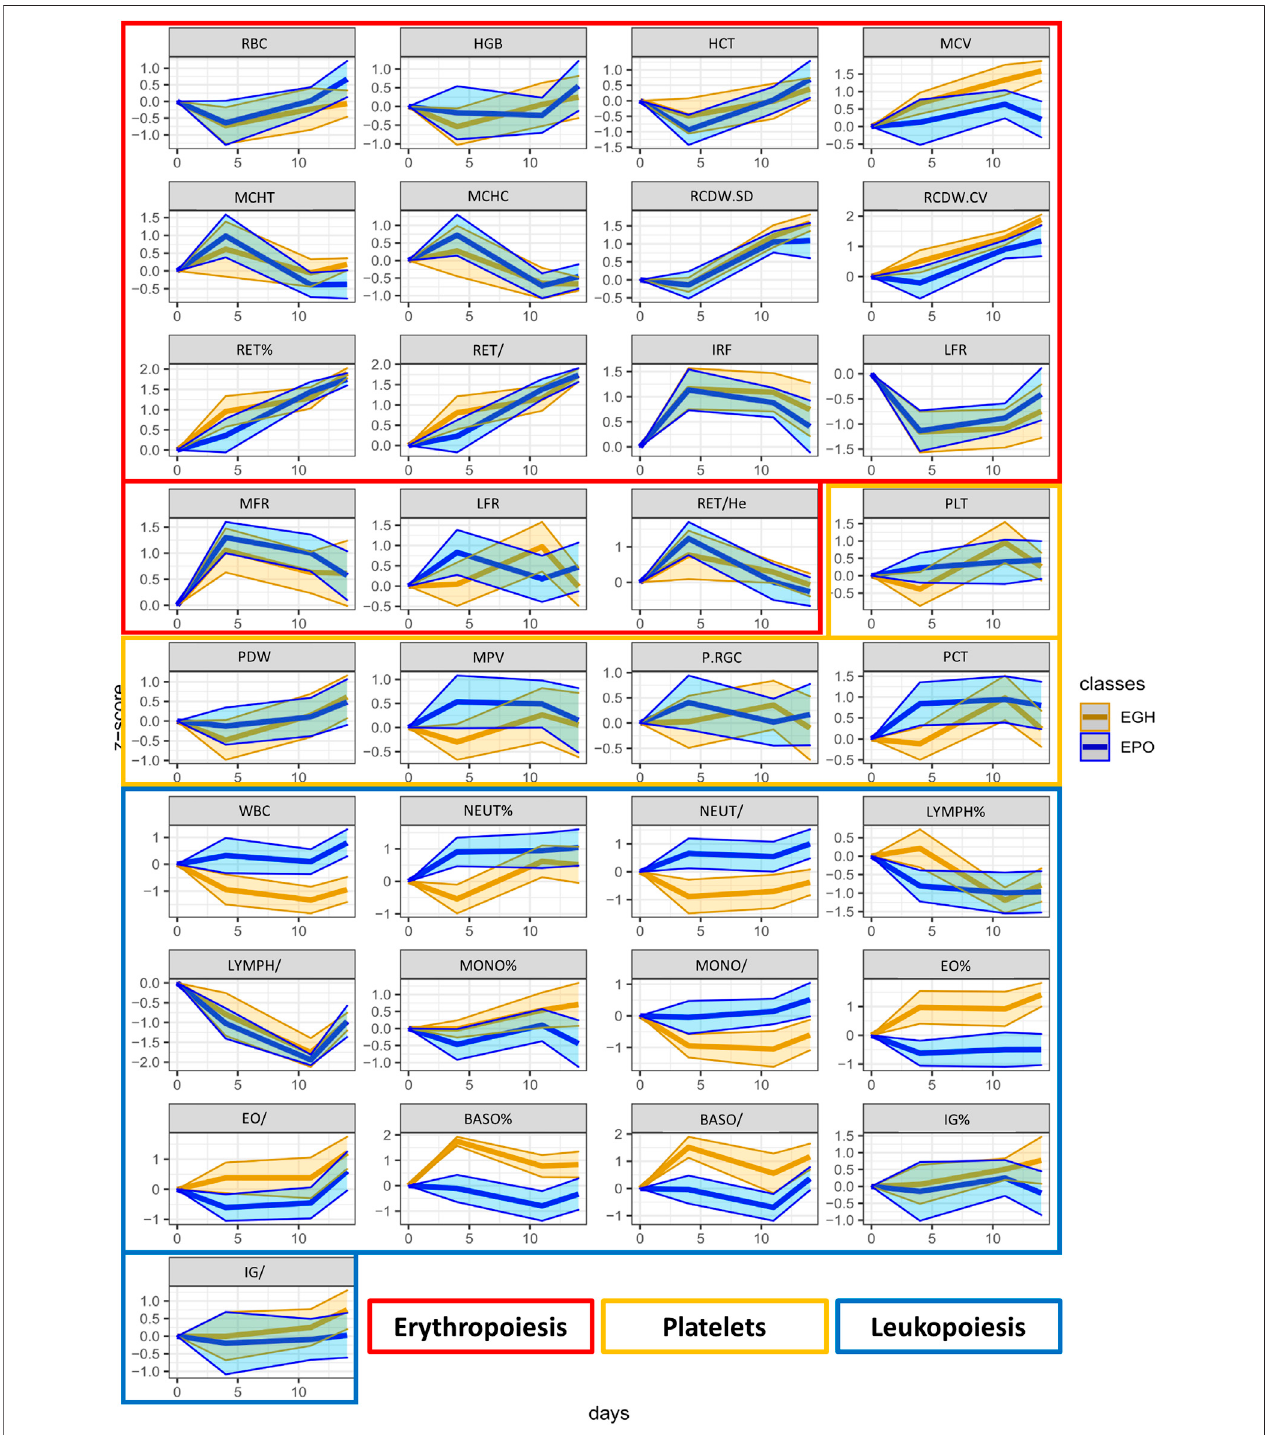
FIGURE4| Thetrendplotsofallthehematopoieticparametersmeasuredinourtwotreatedgroups(EPOinredandEGHingreen).Thecoloredareasrepresentthe trends across the time-points. The area is measured as ± 1 standard deviation from the mean value.